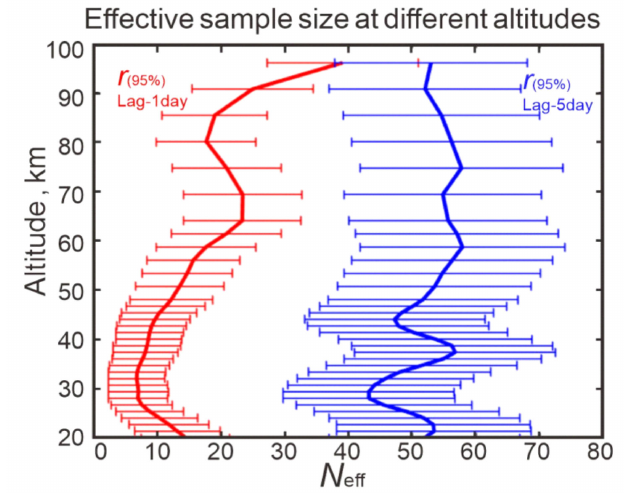
Figure 6. Vertical dependence of effective sample size N eff for time series of wave 1 and wave 2 with autocorrelations with time lags 1 day (red curve) and 5 days (blue curve). In the mesosphere, N eff decreases to 20–30 days with lag-1 autocorrelation but in- creases to ~55 days with lag-5 autocorrelation (red and blue curves in Figure 6, respectively). As N eff increases with longer lags, the 95% confidence intervals narrow, as shown by the dashed curves in Figure 7.